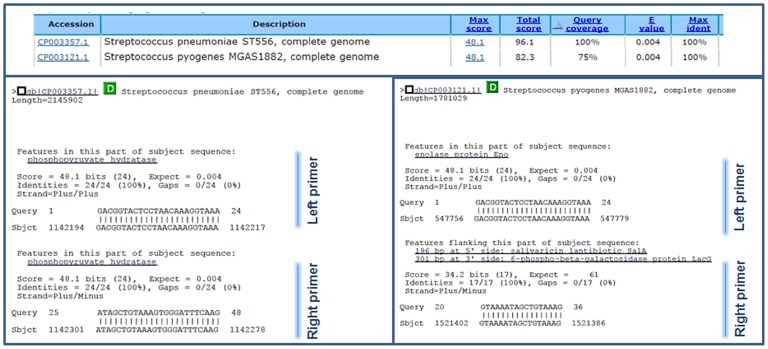

In silico analysis of the especificity of primers to amplify the eno gene.Sequences of primers designed to ampify the S. pneumoniae eno gene were entered into the BLAST website. Among others, total query coverage of 100% and 75% was observed for S. pneumoniae strain ST556 or S. pyogenes MGAS1882, respectively. Left bottom panel shows that both the left and right primers in silico hybridyzed on the S. pneumoniae eno gene. Right bottom panel shows hybridization of only the left primer on the S. pyogenes eno gene. Part of the righ primer in silico hybridized somewhere else in the genome.